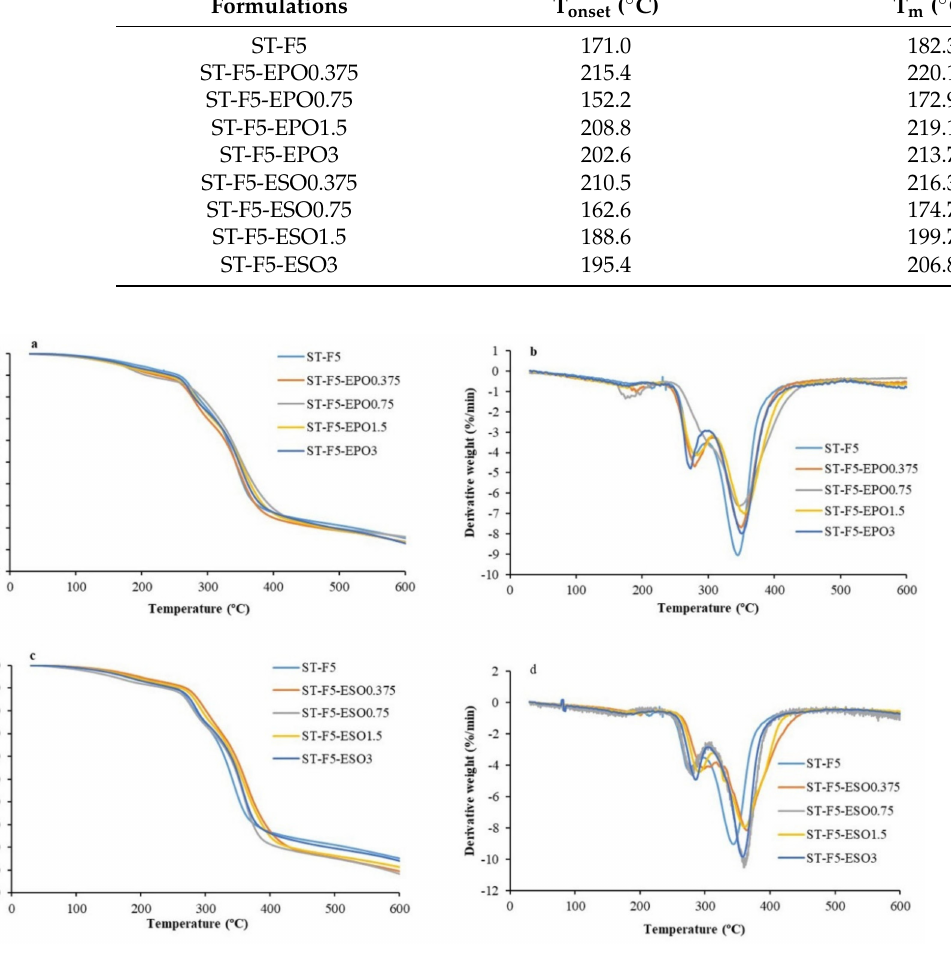
Figure 5. Thermal degradation curves of all the bioplastics. ( a ) TG curves of the bioplastic composites with EPO, ( b ) DTG curves of the bioplastic composites with EPO, ( c ) TG curves of bioplastic composites with ESO, and ( d ) DTG curves of the bioplastic composites with